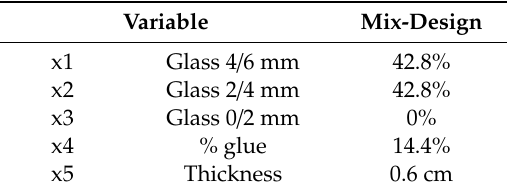
Table 11. Optimal mix-design for both mechanical and optical